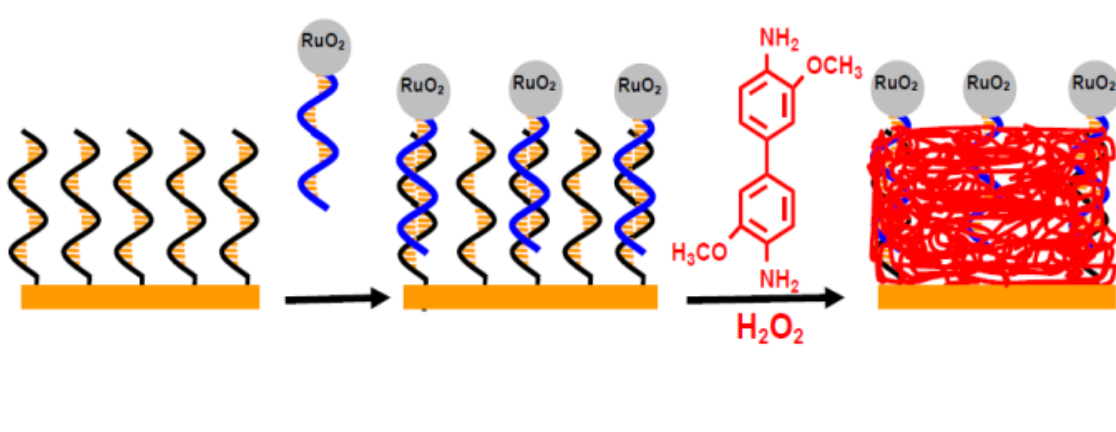
Figure 2. Schematic illustration of the miRNAs biosensor based on RuO miRNAs-templated deposition of a thin PBD insulating film. Reprinted with permission from [19]. Copyright 2011 American Chemical